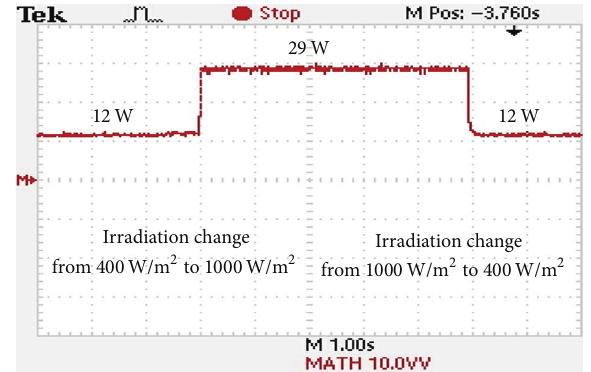
Figure 18: Experimental results for SMESC performance given step change in irradiance from 400W/m 2 to 1000W/m 2 followed by step change from 1000W/m 2 to 400 W/m 2